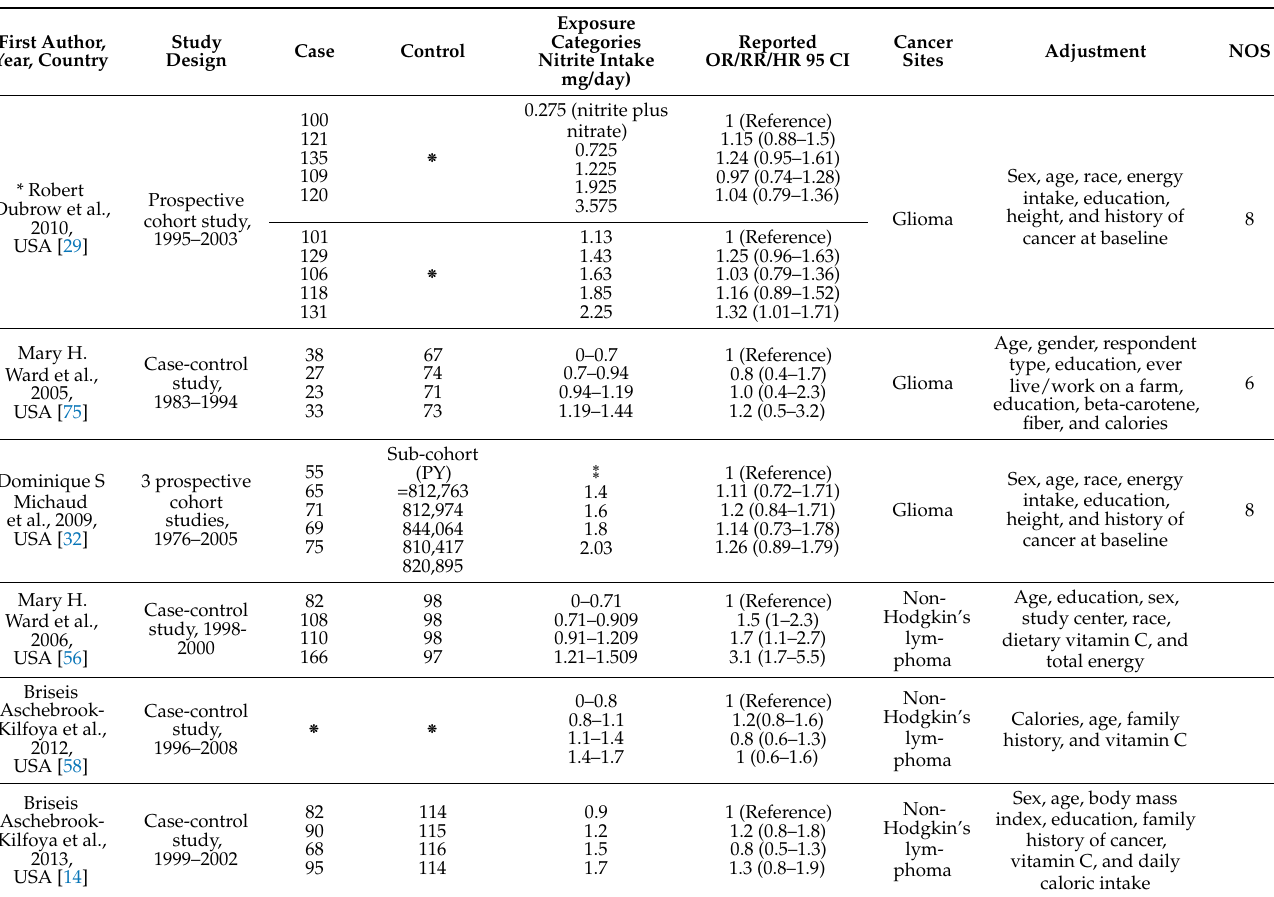
Table 3. Characteristics of the included studies and reported associations between dietary nitrite (mg/day) and cancer